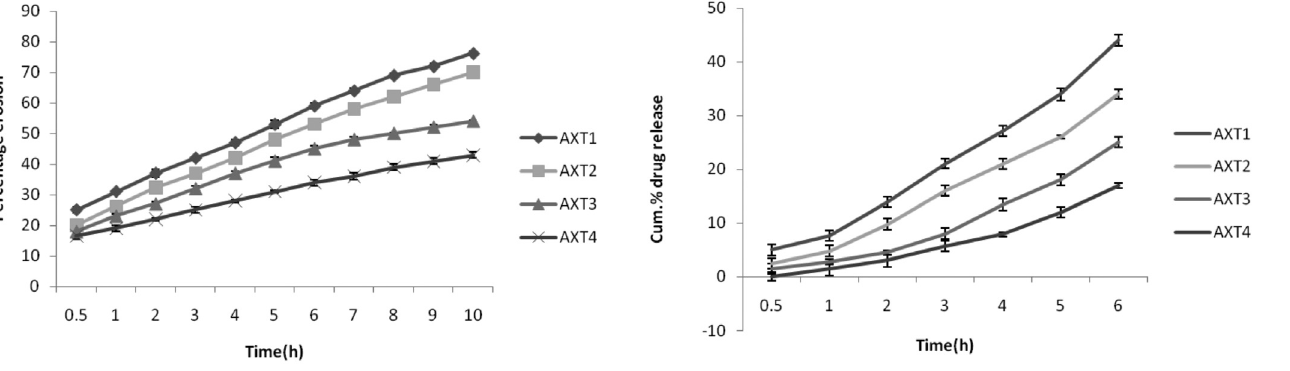
FIGURE 4 - Percentage erosion of aceclofenac-xanthan gum tablets (AXM 1 to AXM 4).